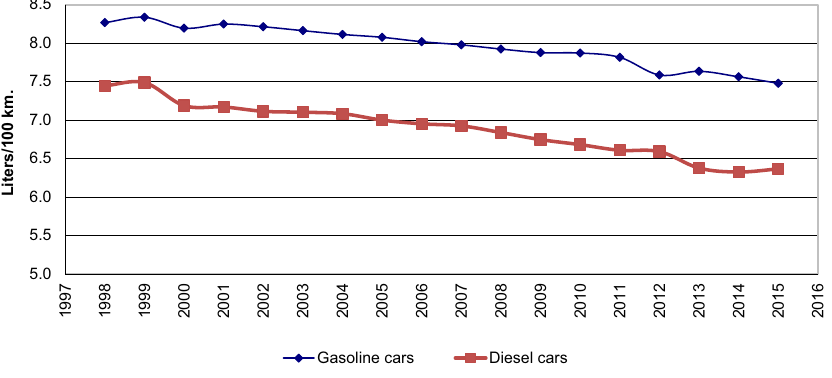
Fig. 2 Fuel intensity of diesel and gasoline car fleet in main Western EU countries (liters per 100